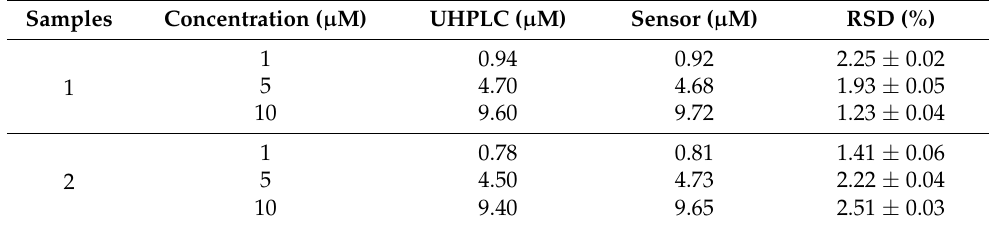
Figure 11. ( A ) Anti-interference ability of NF/IL/CMC-MWCNTs/GCE in 50 mM pH 5 PBS contain- ing 250 μM different interfering substances (ethanol, Glu, Vit B1, Vit C, Gly, UA, inositol, nitrite, sulfite, levodopa, amoxicillin, urea, clotrimazole, pyrogallic acid) and 0.5 μM rutin. ( B ) Stability of NF/IL/CMC-MWCNTs/GCE. ( C ) The voltammograms of the interference study. ( D ) The voltammo- grams of the stability study. ( E ) The voltammograms of the reproducibility study. Table 2. Rutin-tablet sample determination by UHPLC and electrochemical-sensor methods (n =